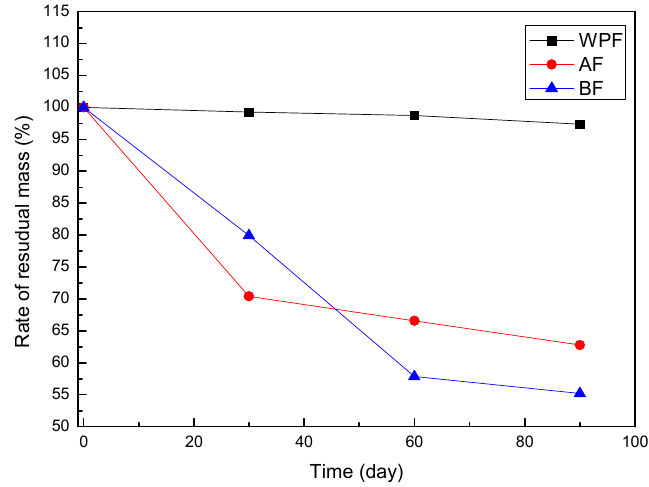
Figure 5. Rate of residual mass of windmill palm fiber (WPF), alkali-treated fiber (AF), and bleached fiber (BF), before and after biodegradation.